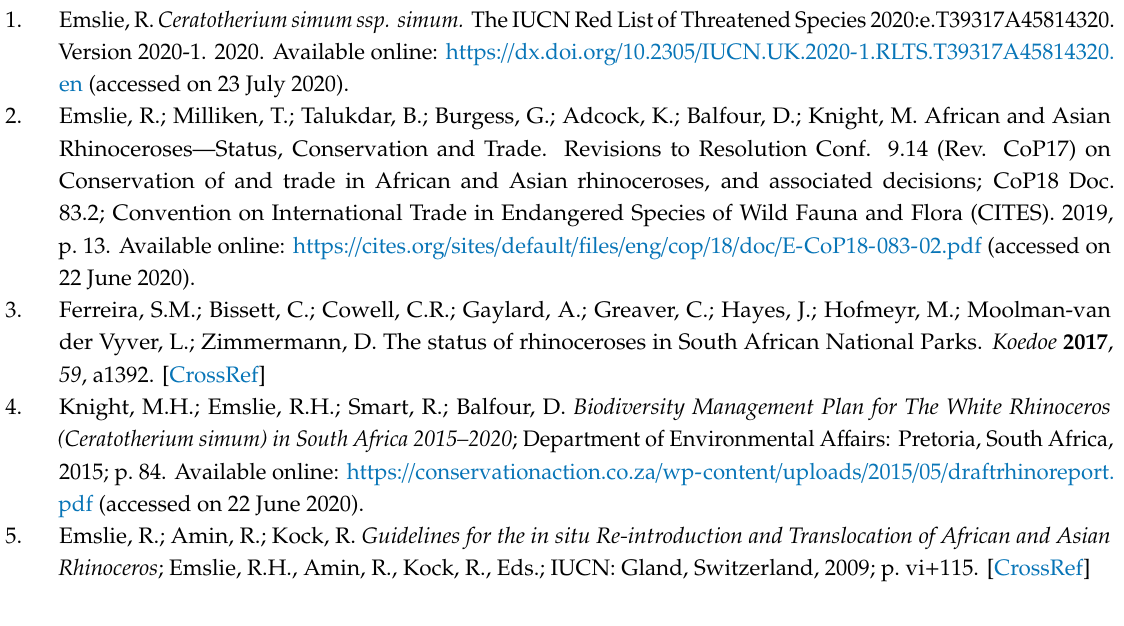
Table S1: Mean ± standard deviation for measured clinical chemistry analyte concentrations used to calculate, or interpret, dependent acid-base variables: sodium (Na + ), potassium (K + ), chloride (Cl − ), ionized calcium (iCa ++ ), magnesium (Mg), inorganic phosphorus (Pi), albumin, globulin, glucose, urea, and creatinine in rhinoceroses captured and transported with either azaperone (group A) or midazolam (group M). Time: capture (TC), start of transport (T0), and two (T2), four (T4) and six (T6) hours of